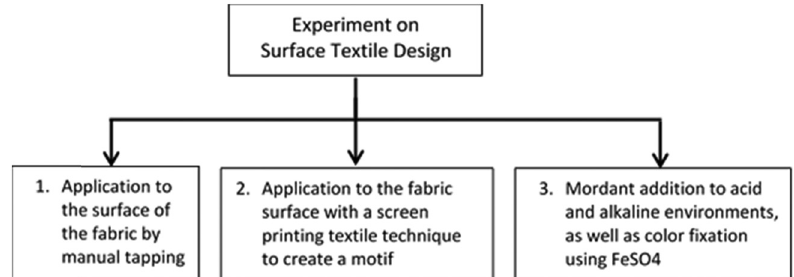
Figure 1: The experimental process stage of applying color to fabrics with surface textile design